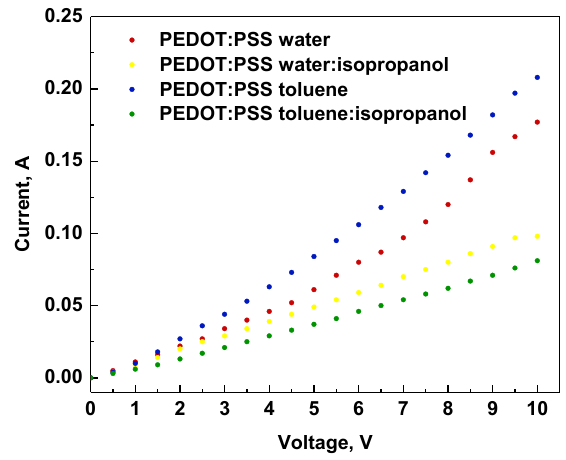
Figure 10. The correlation of current with applied potential for constructed devices containing PEDOT:PSS from water, water:isopropanol, toluene, and toluene:isopropanol.